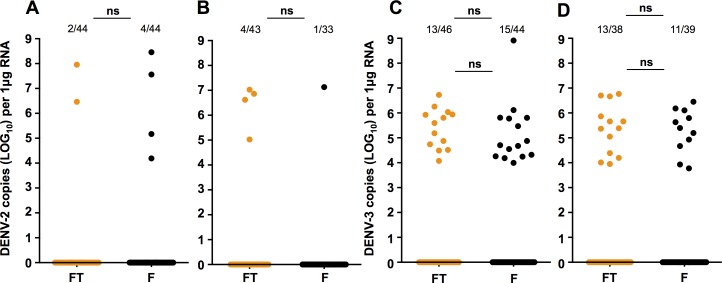
DENV-2 or DENV-3 oral infection in Aedes fluviatilis.Prevalence of infection and DENV load for Ae. fluviatilis orally challenged with DENV-2 at 7 dpi (A) and 14 dpi (B), or DENV-3 at 7 dpi (C) and 14 dpi (D), as determined via RT-qPCR with absolute quantification. Data represent 2 independent infections. FT (orange)—Flu.Tet. F (black)—Flu. Prevalence data analysed by Fisher’s exact test. DENV load data analysed by Mann-Whitney U test. ns = P > 0.05. Black lines represent treatment medians.